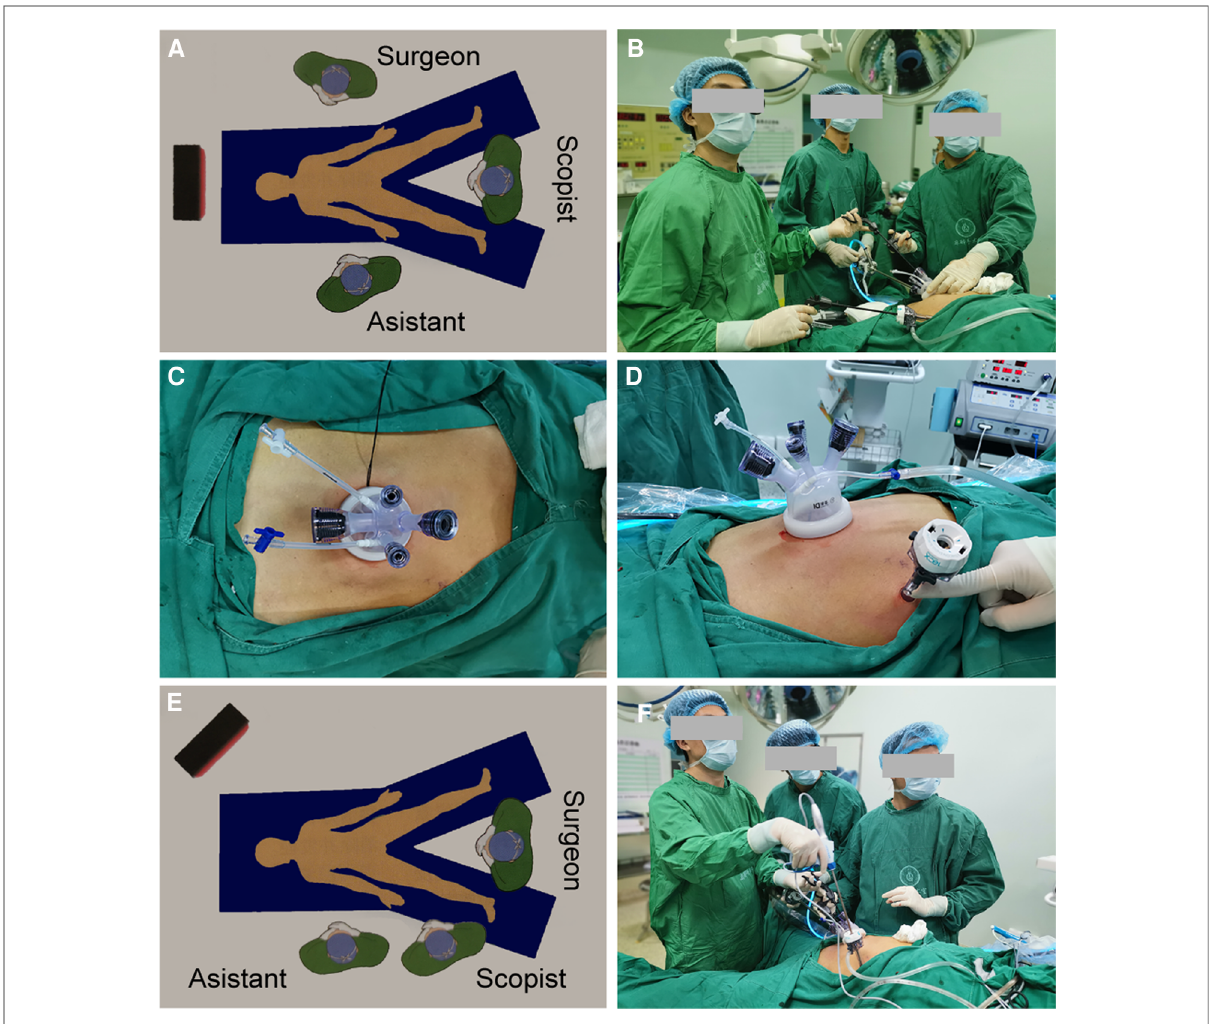
FIGURE 1 ( A,B ) Diagram illustrating the surgical fi eld setup at the beginning of the surgery. ( C,D ) A commercial four-hole wound-protecting device was inserted into a transumbilical incision, and an 12-mm additional assistant trocar was placed as an auxiliary operating hole 2 cm below the costal margin of the anterior axillary line in the upper left abdomen. ( E,F ) When the surgeon cleaned the lymph nodes on the left side of the greater curvature of the stomach, the surgeon moved from the patient ’ s left side to between the patient ’ s legs, with the fi rst assistant and the other assistant holding the lens while standing on the right side of the